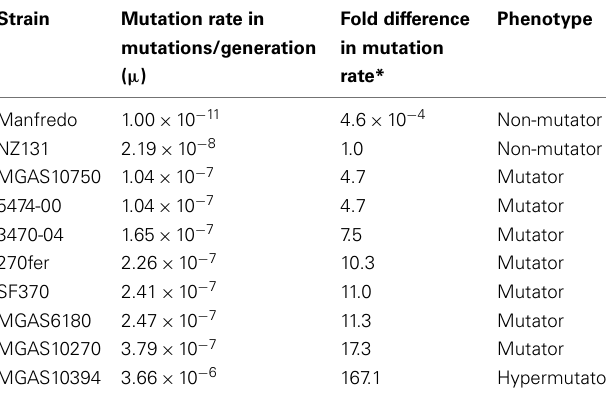
Table 3 | Calculated mutation rates from fluctuation